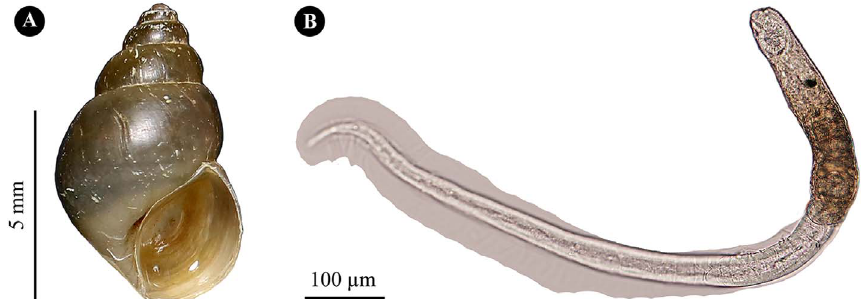
Figure 3. (A) Live Bithynia siamensis siamensis snail and (B) unstained live free-swimming O. viverrini s.l. cercaria in the bent-billiard tobacco pipe form at resting and fl eetingly hanging times.